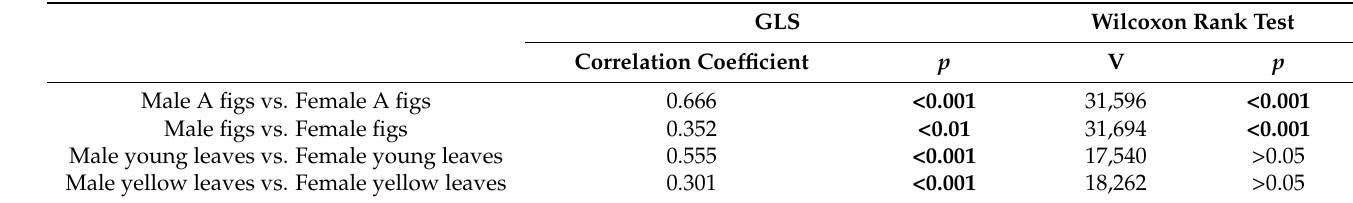
Table 1. Generalized least squares (GLS) models with autocorrelated errors and the Wilcoxon signed rank tests between male and female phenological production by branch. V is the statistic associated with the Wilcoxon rank test.